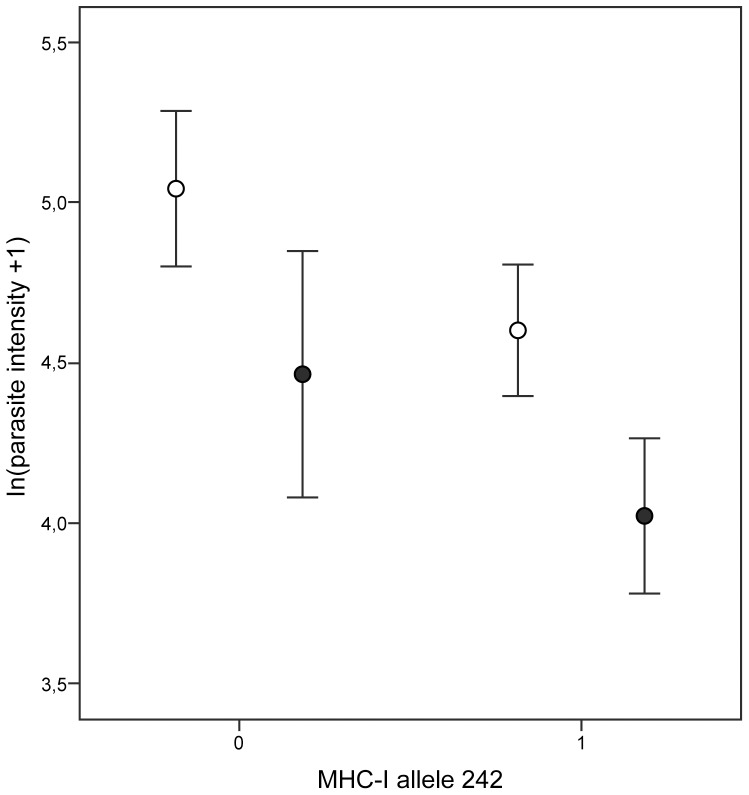
MHC allele 242 suppresses the H. majoris infection in both young and old birds.
H. majoris infection intensity (ln(parasite infection intensity+1)) in blue tits, aged 2Y (open circles) or 3Y+ (filled circles), that carry or do not carry the MHC-I allele 242 (mean±2SE). Allele 242 suppresses the H. majoris infection in all birds although young birds (2Y) have higher infection intensities.